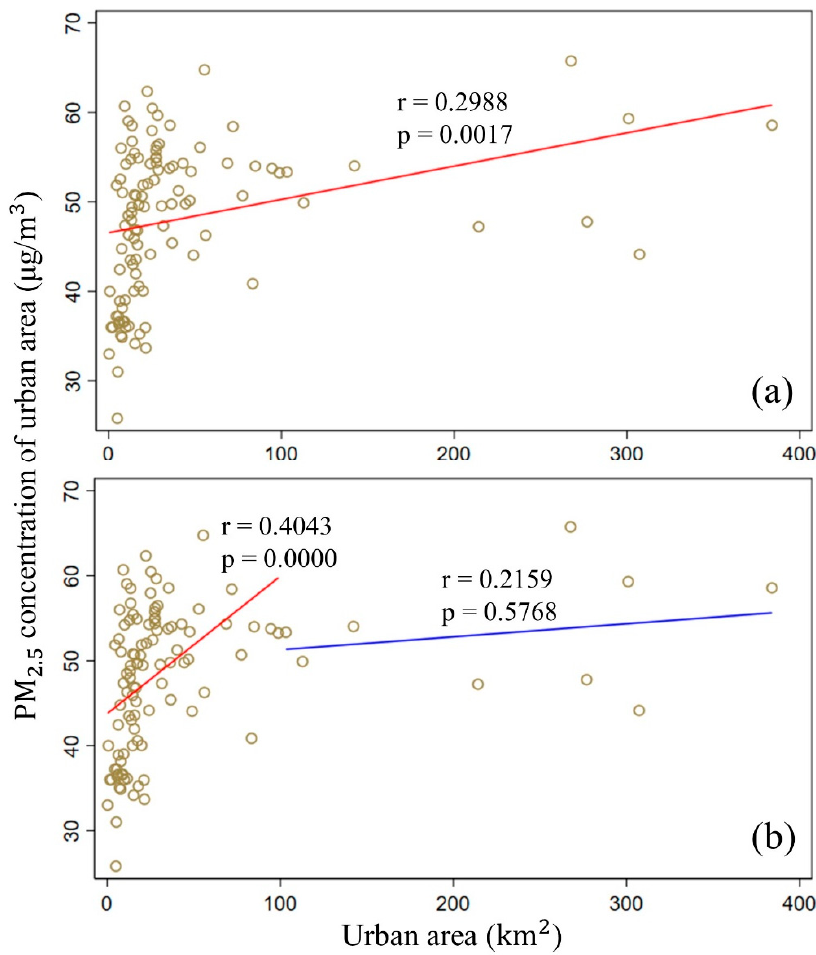
Figure 10. Relationship between the area and PM 2.5 concentration in the urban areas. ( a ) All urban areas; ( b ) urban areas divided at an area of 100 km 2 .